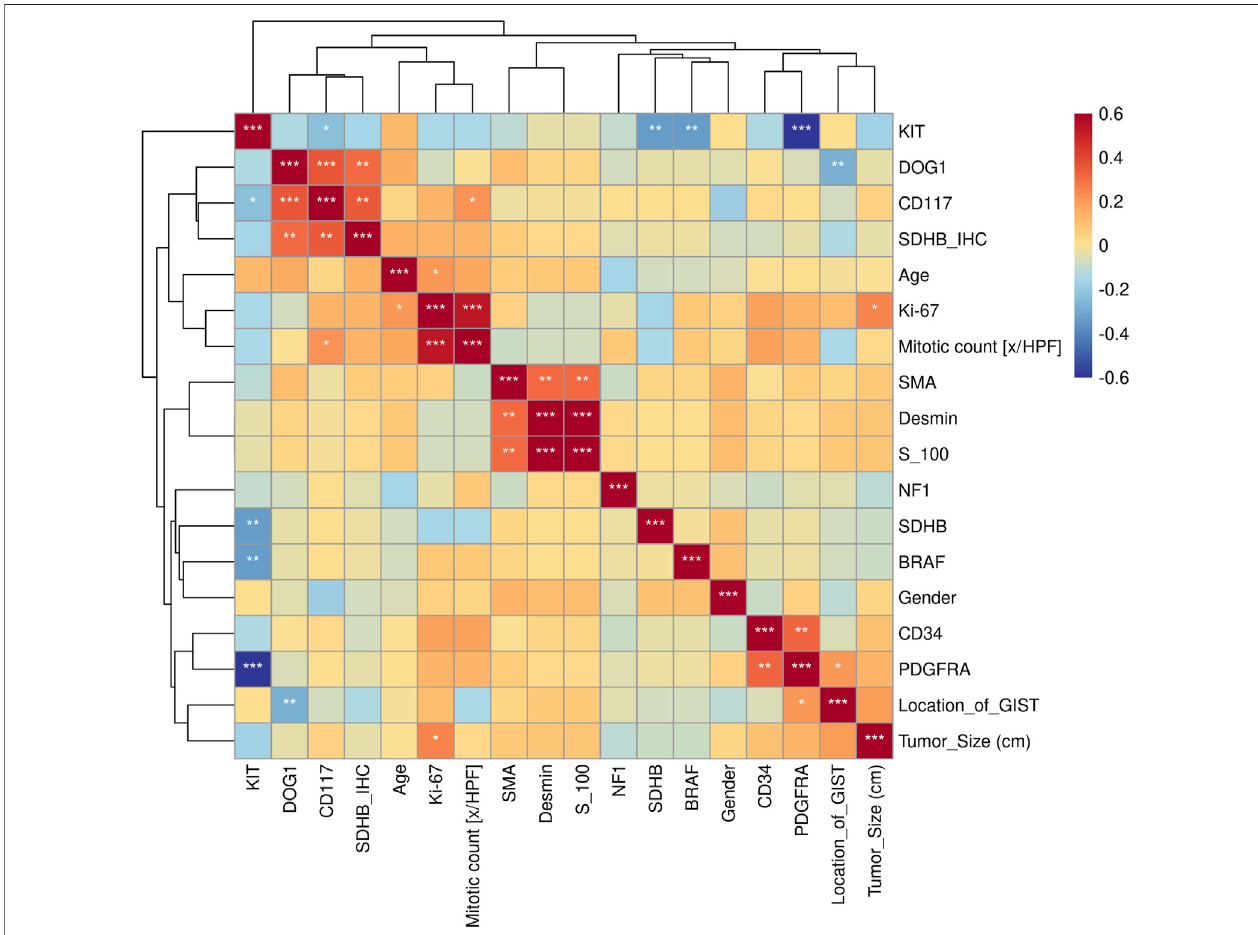
FIGURE 4 | Kendall correlation analysis between gene mutations and clinical features. Test of signi fi cance of the Kendall correlation coef fi cient: “ * ” , “ ** ” , “ *** ” represent p < 0.05, p < 0.01, and p < 0.001, respectively.